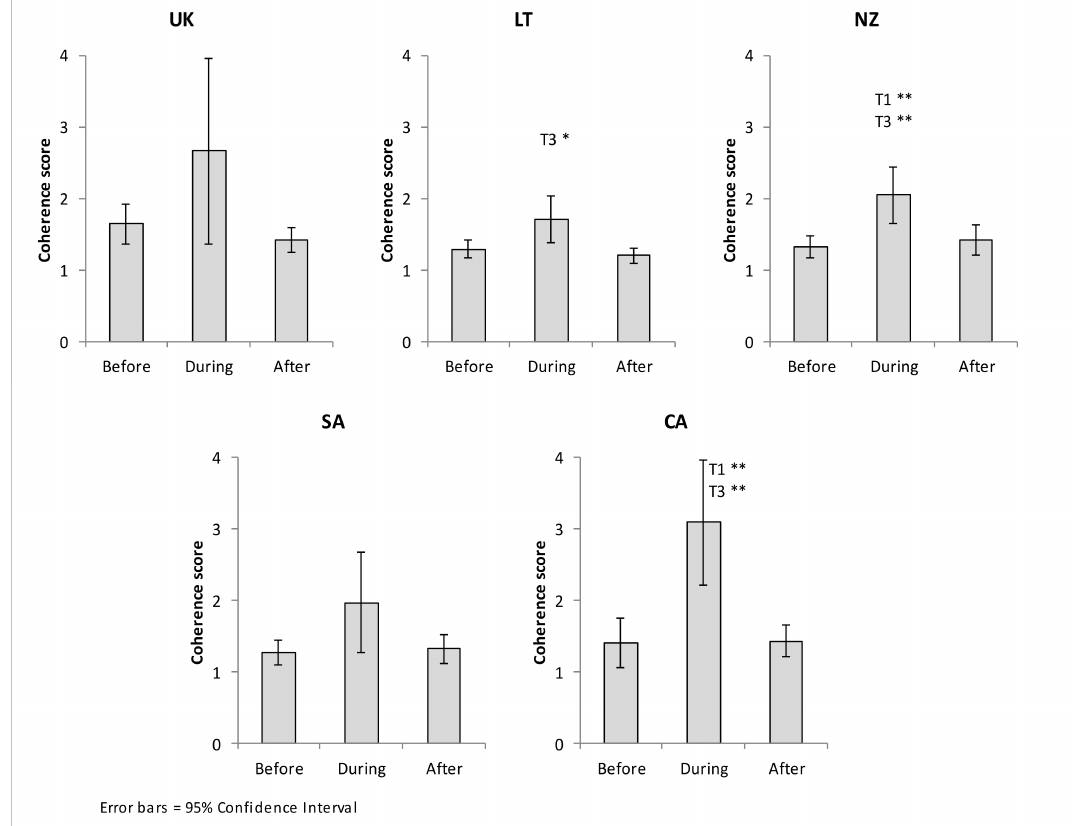
Figure 4. The results of a repeated measures (within-subjects) ANOVA test assessing differences in the coherence score for all five groups during 15-min periods before (T1), during (T2) and after (T3) using the Heart lock-In technique (* corresponds to p < 0.05, ** corresponds to p < 0.001). Note that a coherence score below one is considered as low coherence, scores between one and two as medium, and scores above two as high levels of coherence. It can be seen, for example, that California’s and New Zealand’s group members’ HRV coherence was significantly higher during the HLI period than before and after the HLI period,